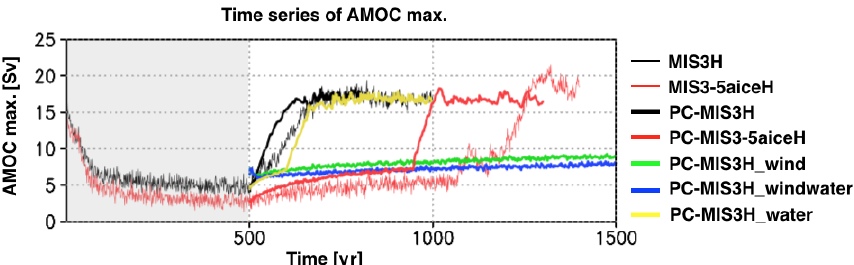
Figure 11. Results from partially coupled experiments. Time series of the strength of the AMOC is shown. Results from the original AOGCM experiments are shown by thin lines, whereas the results from partially coupled experiments are shown in thick lines. Thin black: MIS3H, thin red: MIS3–5aiceH, thick black: PC-MIS3H, thick red: PC-MIS3–5aiceH, thick green: PC-MIS3H_wind, thick blue: PC-MIS3H_windwater, thick yellow: PC-MIS3H_water. Freshwater flux of 0.1Sv is applied during years 0 to 500 (gray-shaded period).